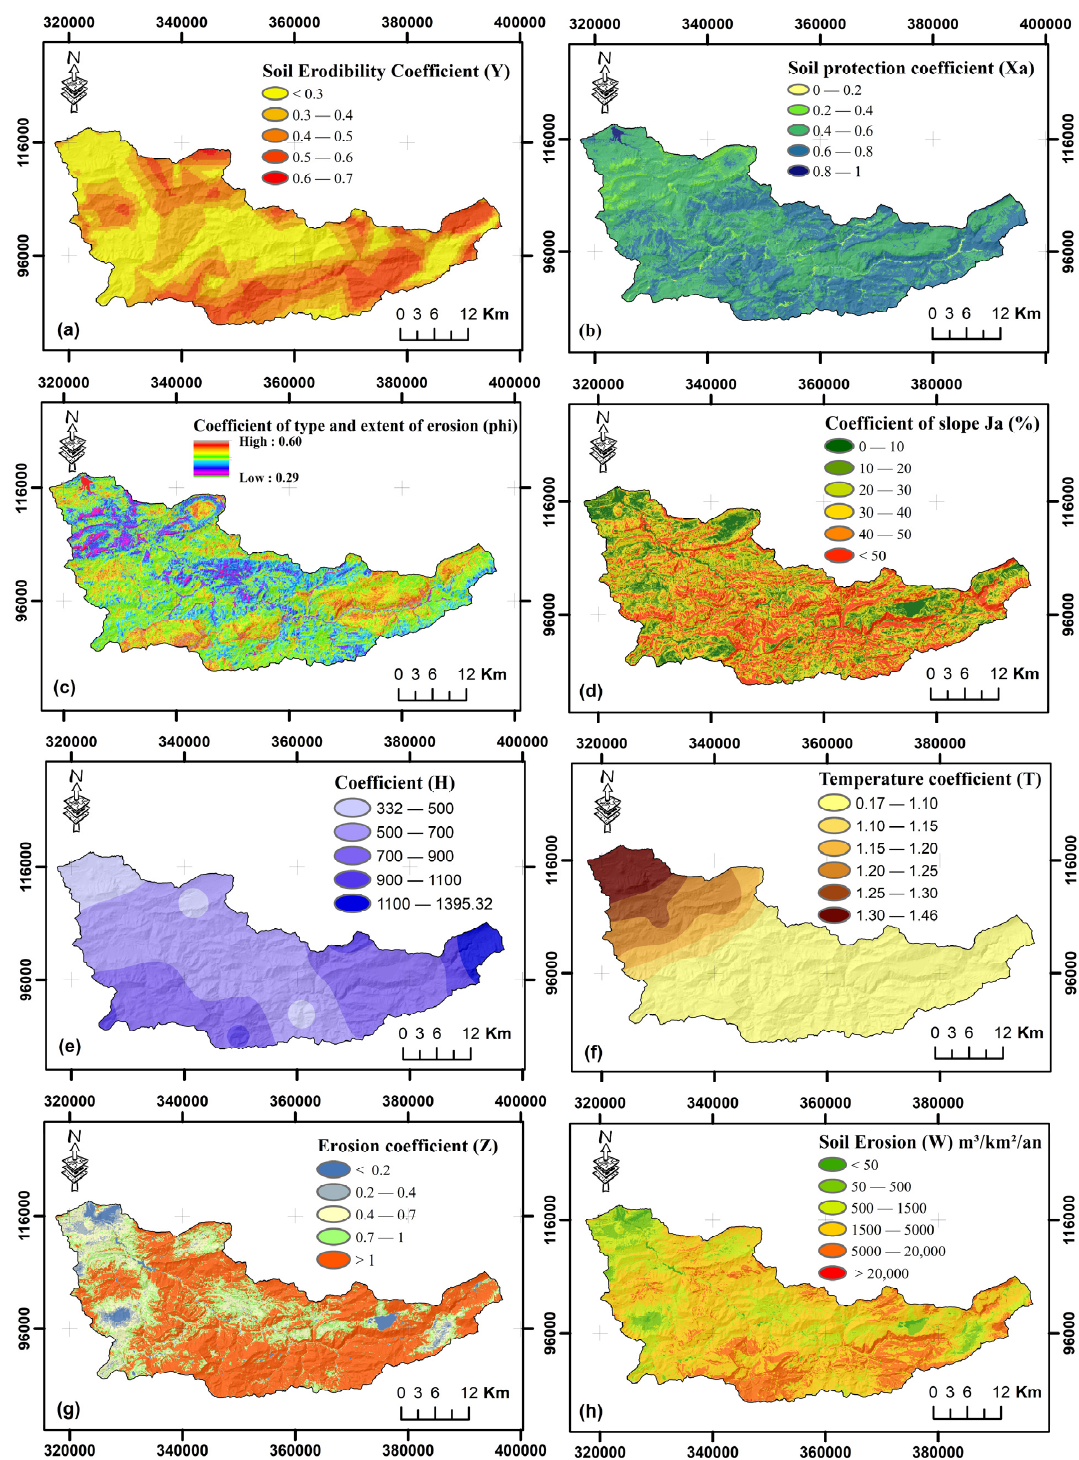
Figure 3. Spatial distribution of EPM parameters; ( a ) soil erodibility coefficient, ( b ) soil protection coefficient, ( c ) type and extent of erosion coefficient, ( d ) topographic coefficient, ( e ) Rainfall-H factor, ( f ) temperature coefficient, ( g ) potential erosion coefficient, and ( h ) soil loss.